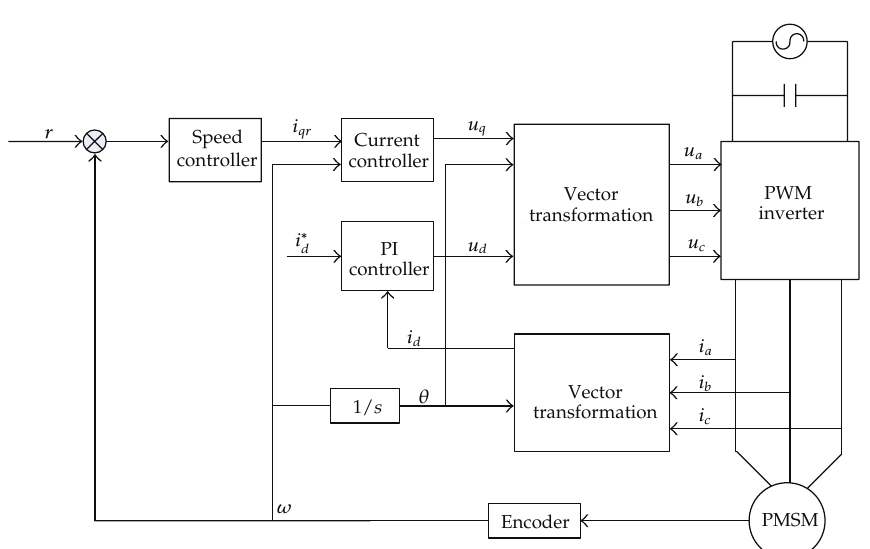
Figure 1: Configuration of a PMSM Servo